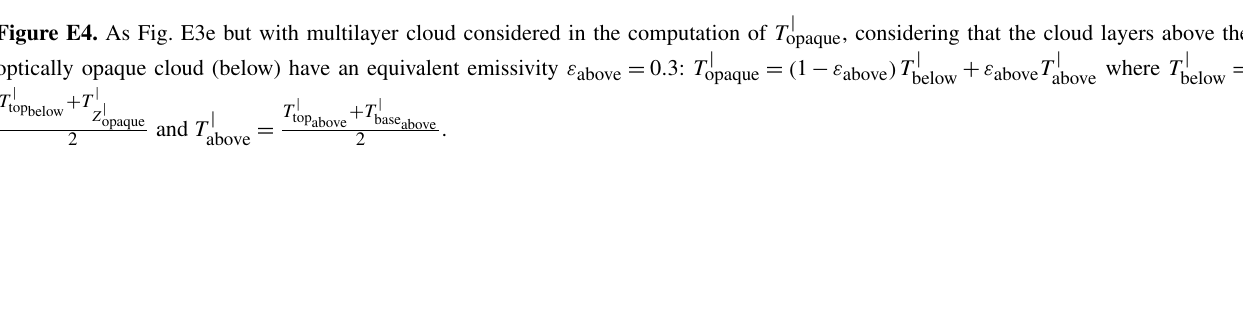
| opaque , considering that the cloud layers above the | | | | = ( 1 − ε + ε = where T opaque above )T above T below above below